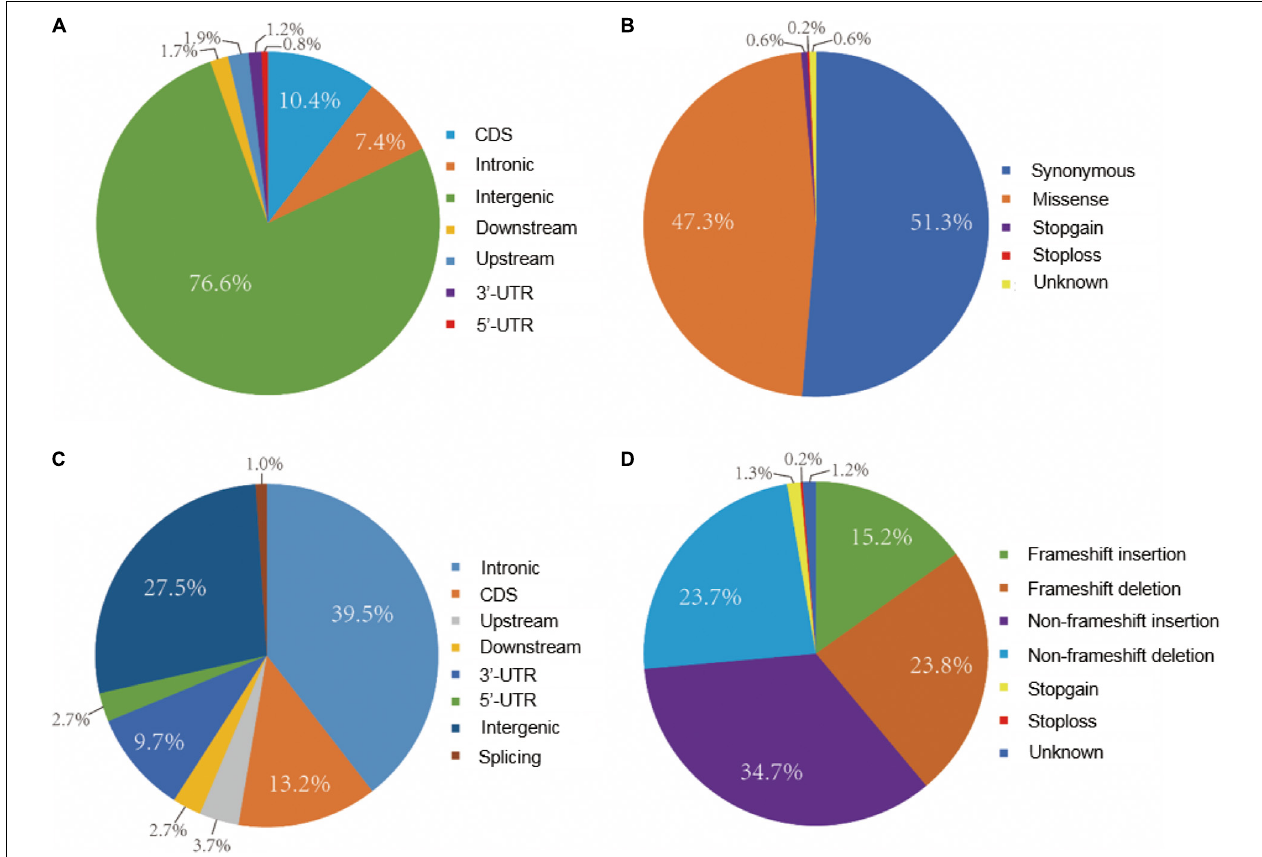
FIGURE 3 | Distribution and functional annotation of exomic variations between eh1 and WT. (A) Frequency of SNPs in different exome regions. (B) Functional annotation of SNPs in gene-coding region. (C) Frequency of Indel in different regions in the exome. (D) Functional annotation of Indels in gene-coding